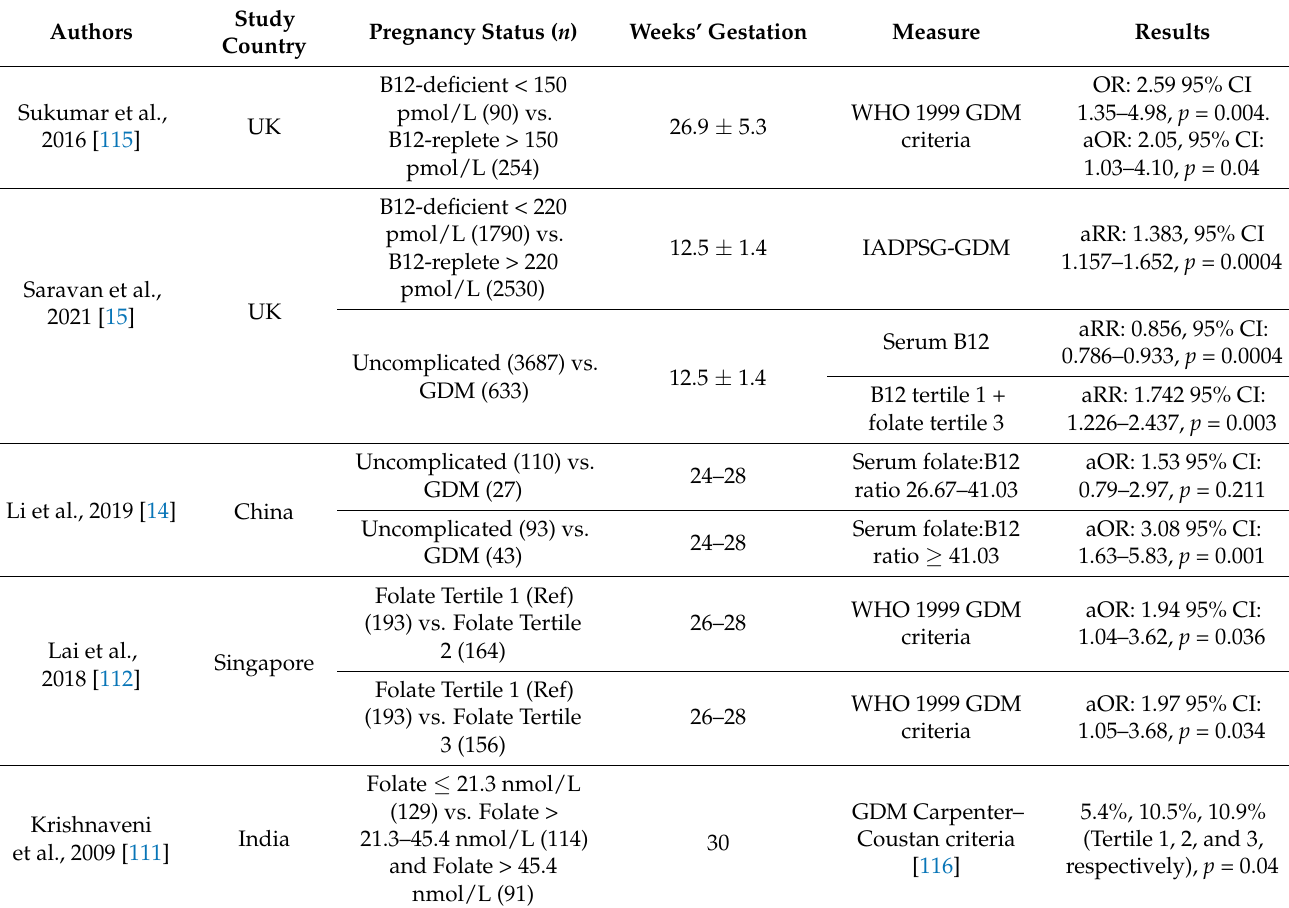
Table 2. Summary of research on the relationship between circulating vitamin B12 and